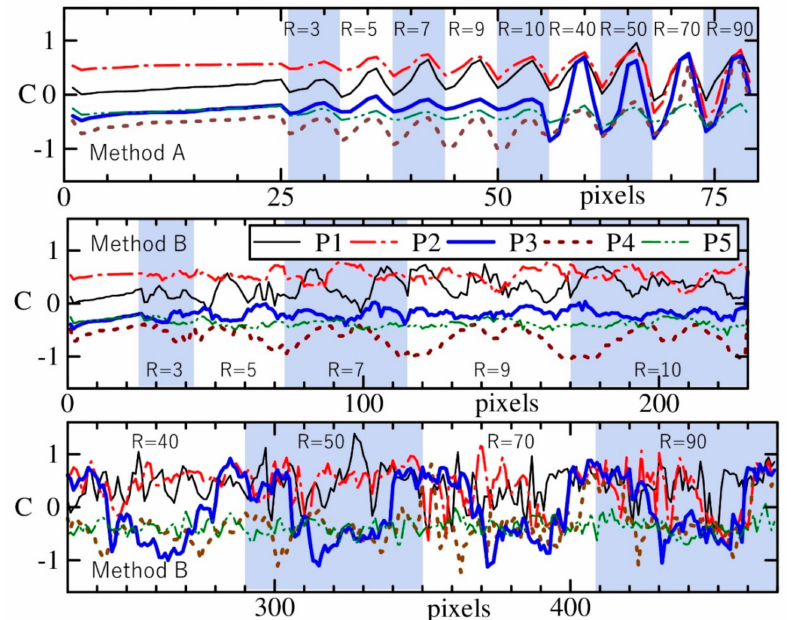
Figure 7. Examples of the extracted data sequence of the input layer in Methods A and B at five different points, P1, P2, P3, P4, and P5, which are shown in Figure 2e. Legends of different lines are both for Methods A and B. P1, P2, and P3 are on the land, and P4 and P5 are on the sea. Shaded rectangles behind the figure indicate the range of the data extracted from different circles with different